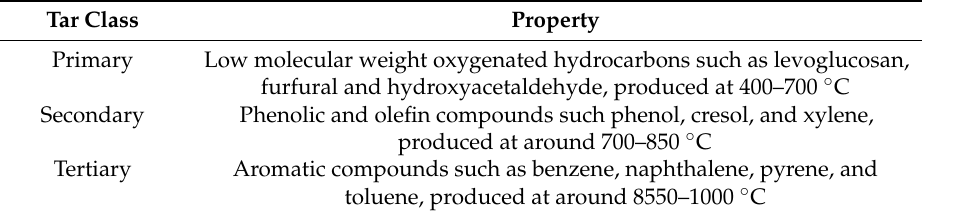
Table 2. Classification of tar based on its appearance [9,10].